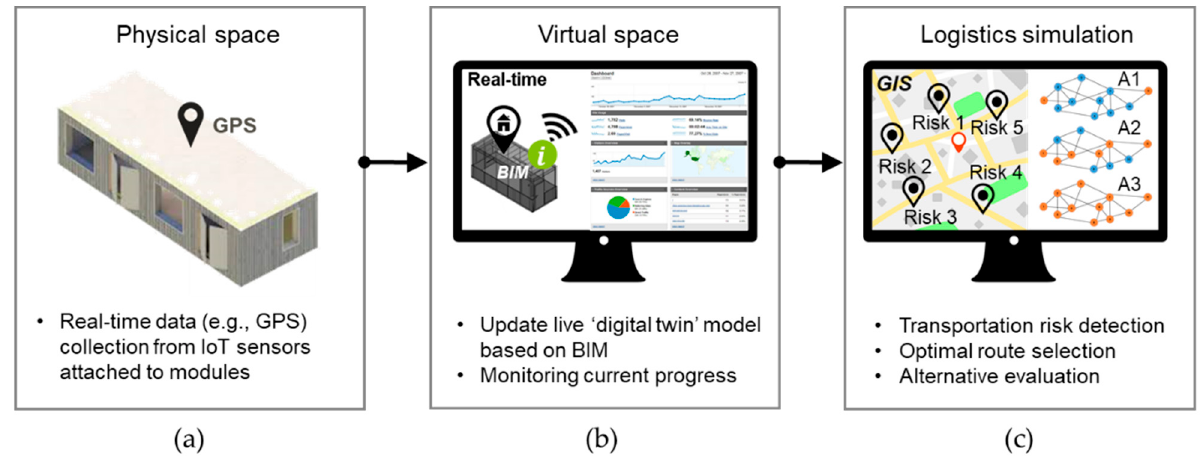
Figure 1. Digital twin framework for real-time logistics simulation in modular construction: ( a ) data collection; ( b ) virtual asset update; ( c ) what-if analysis.